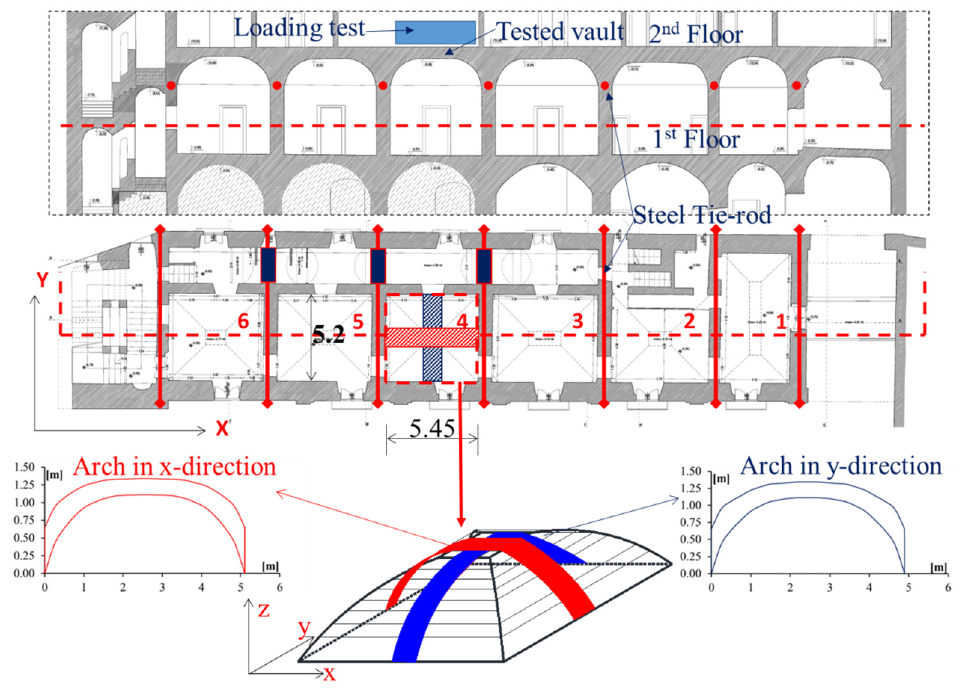
Figure 6. Palazzo Caracciolo di Avellino. Vertical section of the masonry palace ( top ); plan of the masonry palace ( middle ); and examined cloister vault ( bottom center ). The examined cloister vault is divided into the two main arches along the x-direction ( bottom left ) and y-direction ( bottom right ).